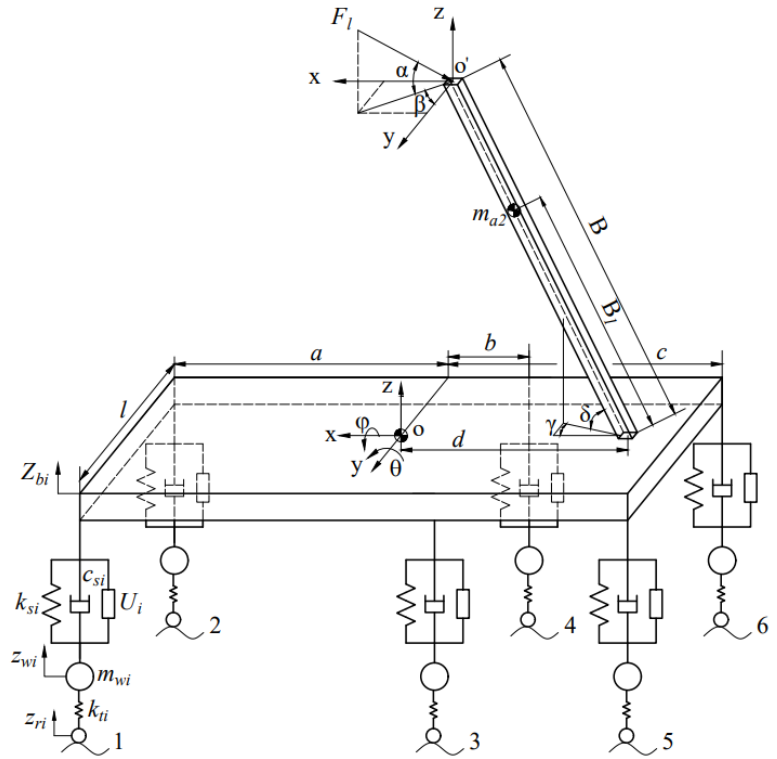
Figure 1. 13-DOF Integrated dynamic